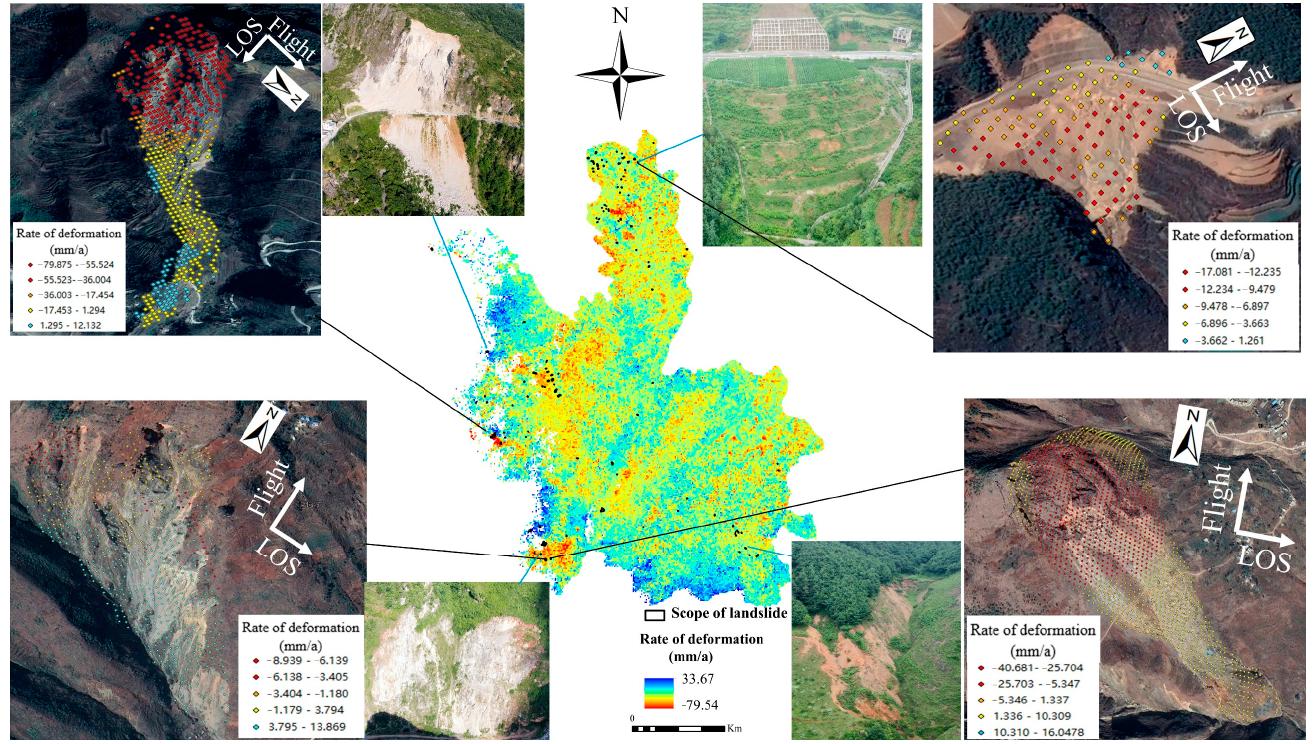
Figure 5. Surface deformation and landslide identification of study area (ascending orbits).